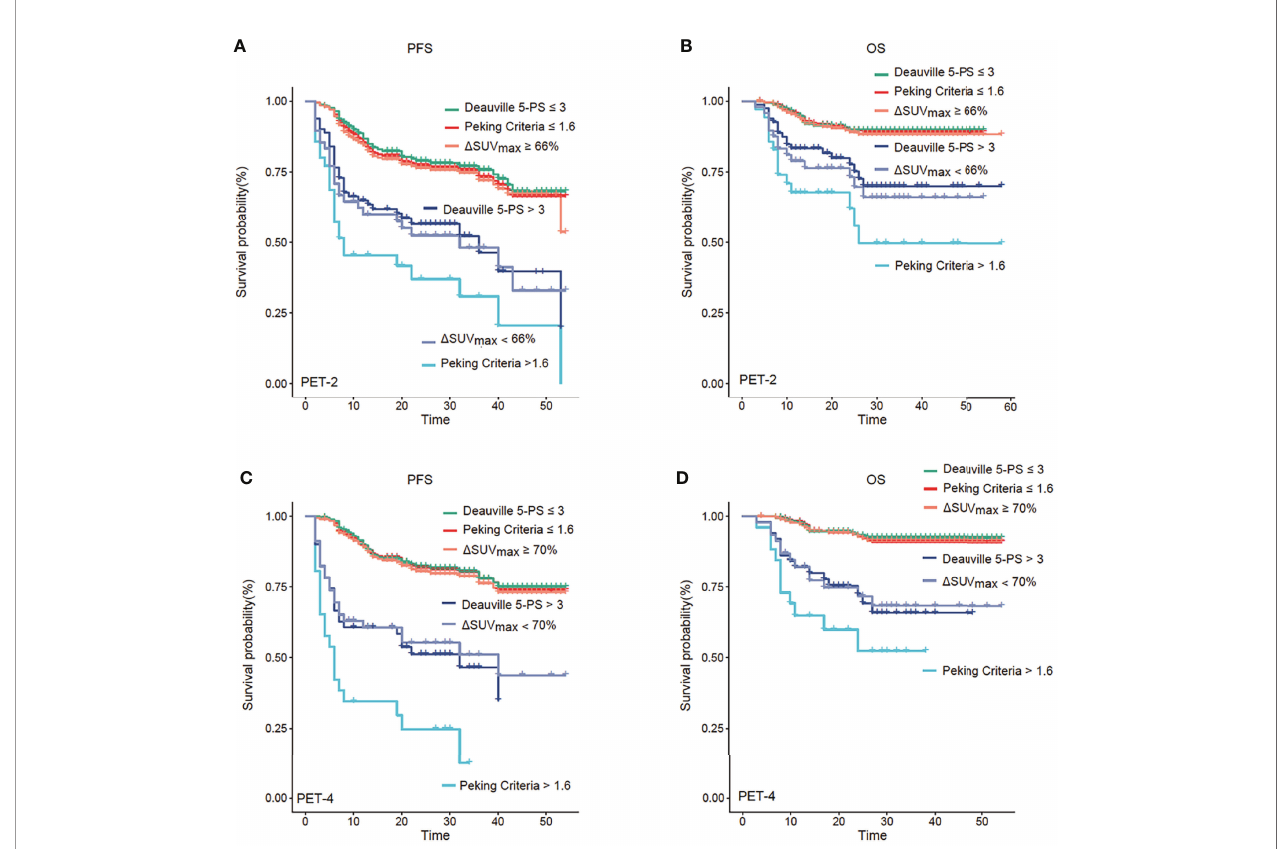
FIGURE 1 | Progression-free survival (PFS) and overall survival (OS) analysis. Kaplan – Meier analysis of PFS and OS according to positron emission tomography (PET) after two cycles of therapy (PET-2) (A, B) and after four cycles of therapy (PET-4) (C, D) . PET-2 and PET-4 investigated by the three image interpretations were strong prognostic factors for both PFS and OS (all P < 0.001). The Peking criteria was superior 5-PS and D SUV max criteria in terms of predicting prognosis.